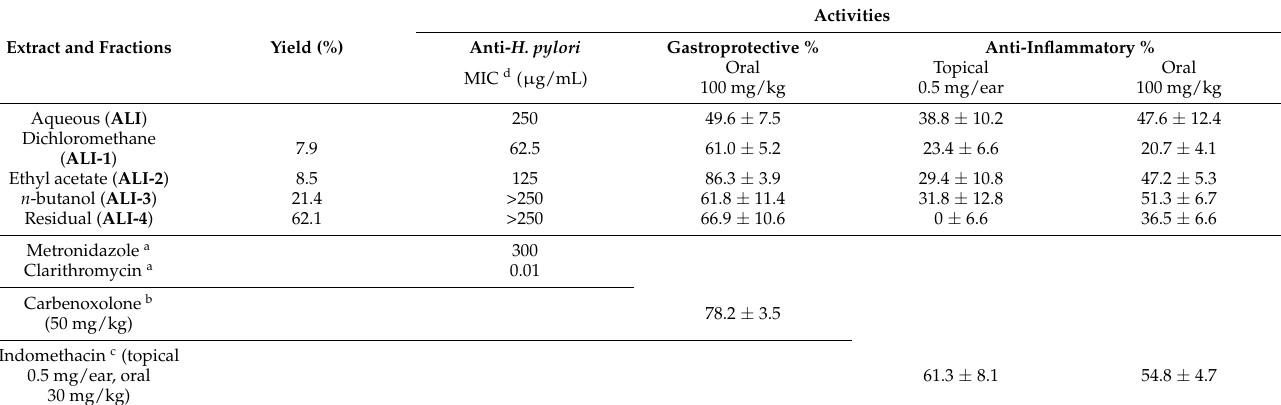
Table 1. Anti- H. pylori , gastroprotective and anti-inflammatory effects of the aqueous extract and organic fractions from A. ludoviciana